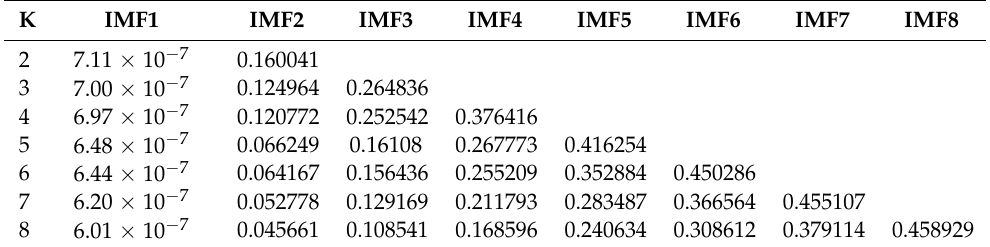
Table 4. Central frequency for the IMF components of the second set of PL.